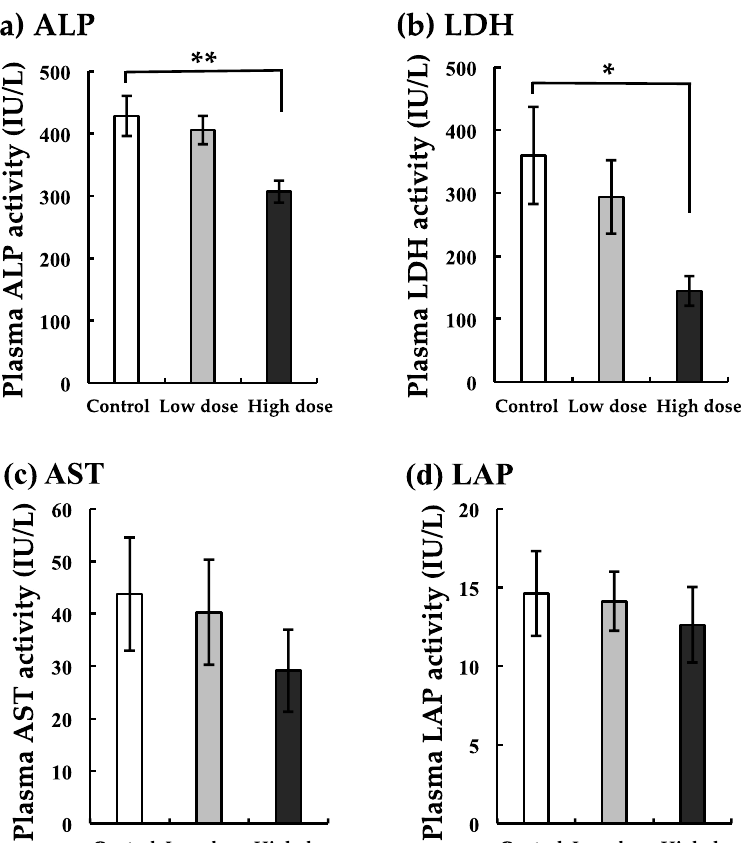
Figure 4. Changes in alkaline phosphatase (ALP) ( a ), lactate dehydrogenase (LDH) ( b ), aspartate transaminase (AST) ( c ), and leucine aminopeptidase (LAP) ( d ) of the liver with BaA treatment. BaA (1 or 10 ng / g body weight) was injected intraperitoneally (four times) into nibbler fish for 10 days during breeding. Thereafter, plasma liver markers were examined in the control and experimental groups. * and ** indicate statistically significant di ff erences at p < 0.05 and p < 0.01, respectively, from the values in the control scales (n = 8). The detection limits of ALP, LDH, AST, and LAP were 2, 6, 3, and 0.4 IU / L, respectively.